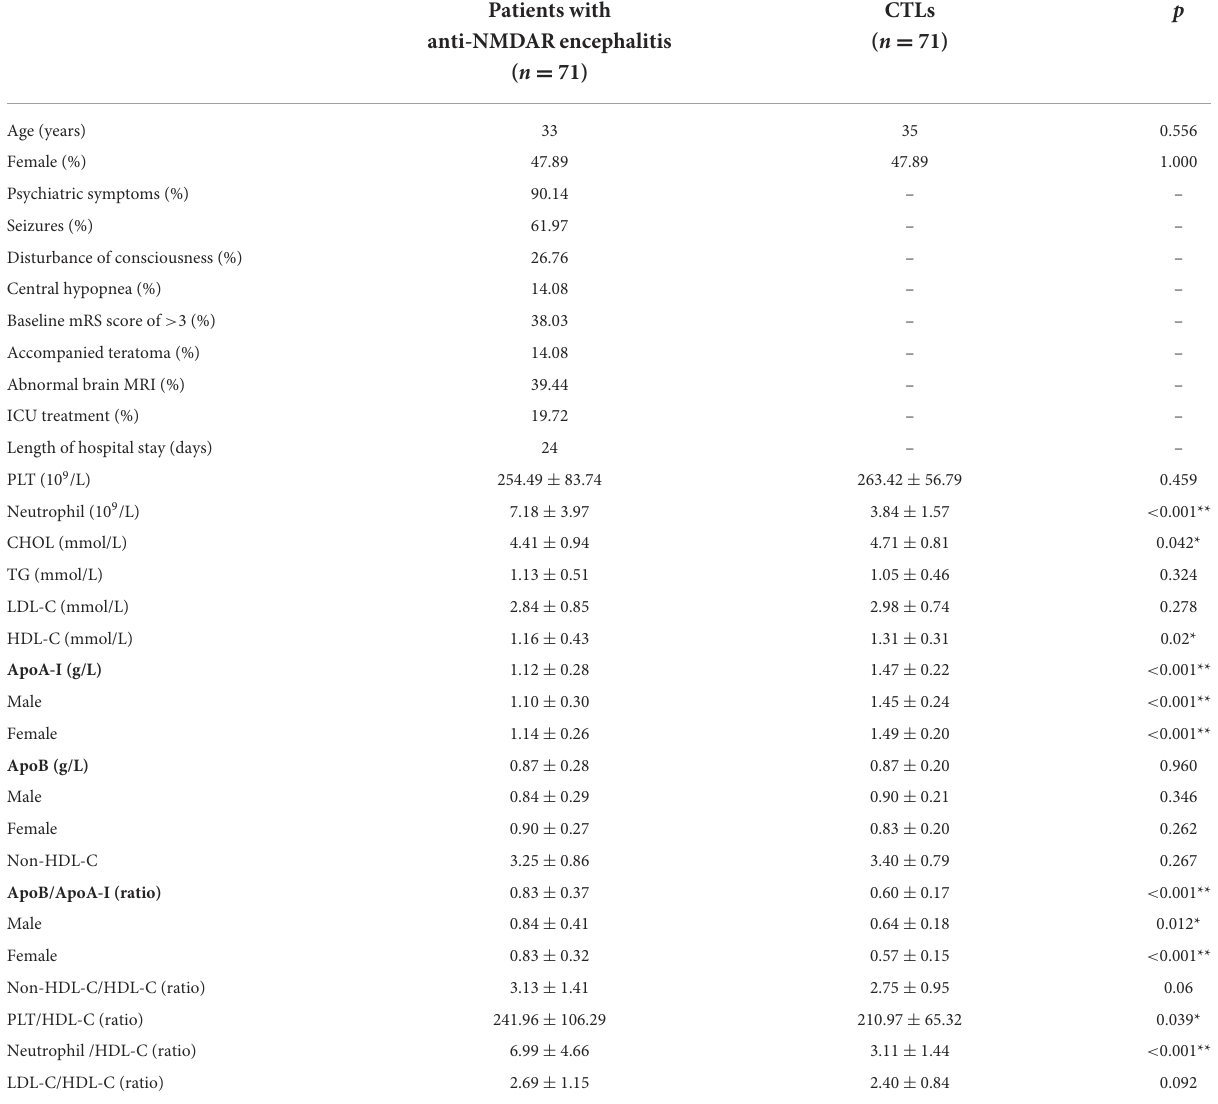
TABLE 1 Baseline characteristics of patients with anti-NMDAR encephalitis and healthy